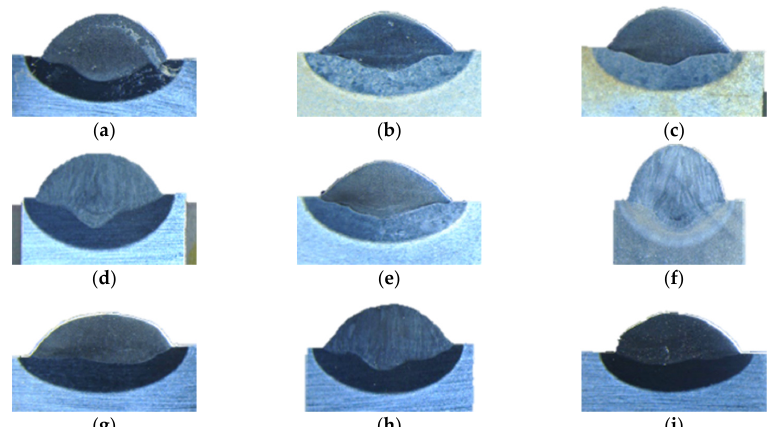
Figure 11. Morphology of weld passes obtained with different process parameters: ( a ) WS: 200